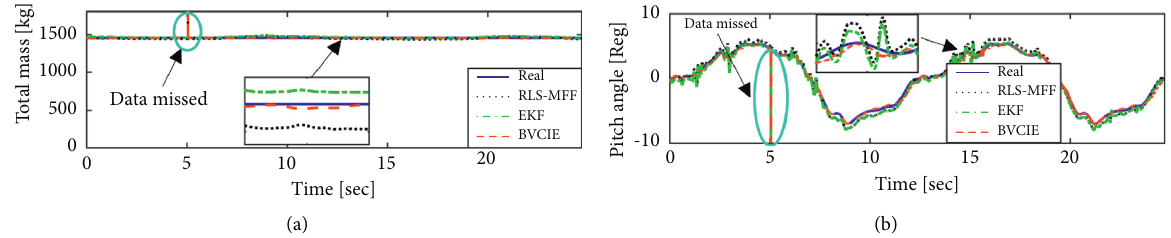
Figure 7: Estimation results by RLS-MFF, EKF, and BVCIE at 40 km/h on asphalt road. (a) Estimated total mass. (b) Estimated pitch angle.